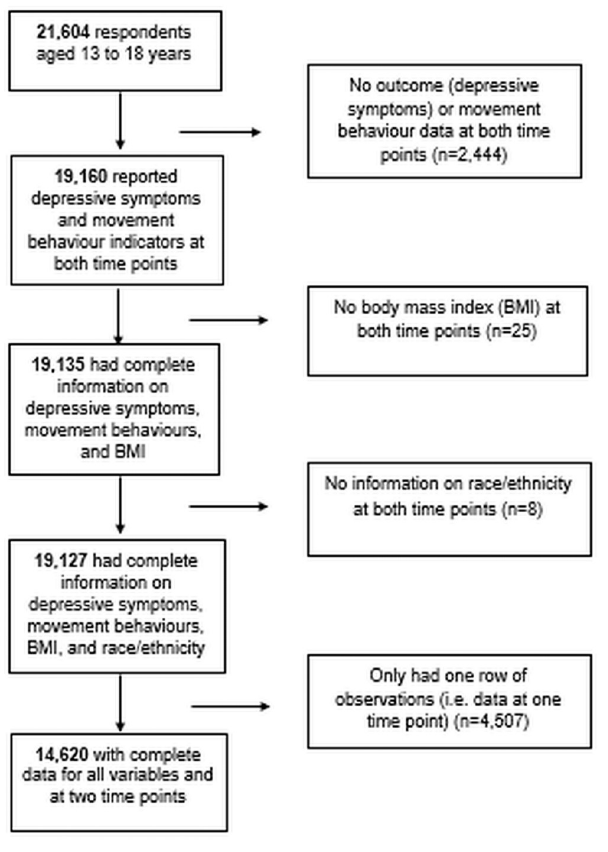
Fig 1. Participant